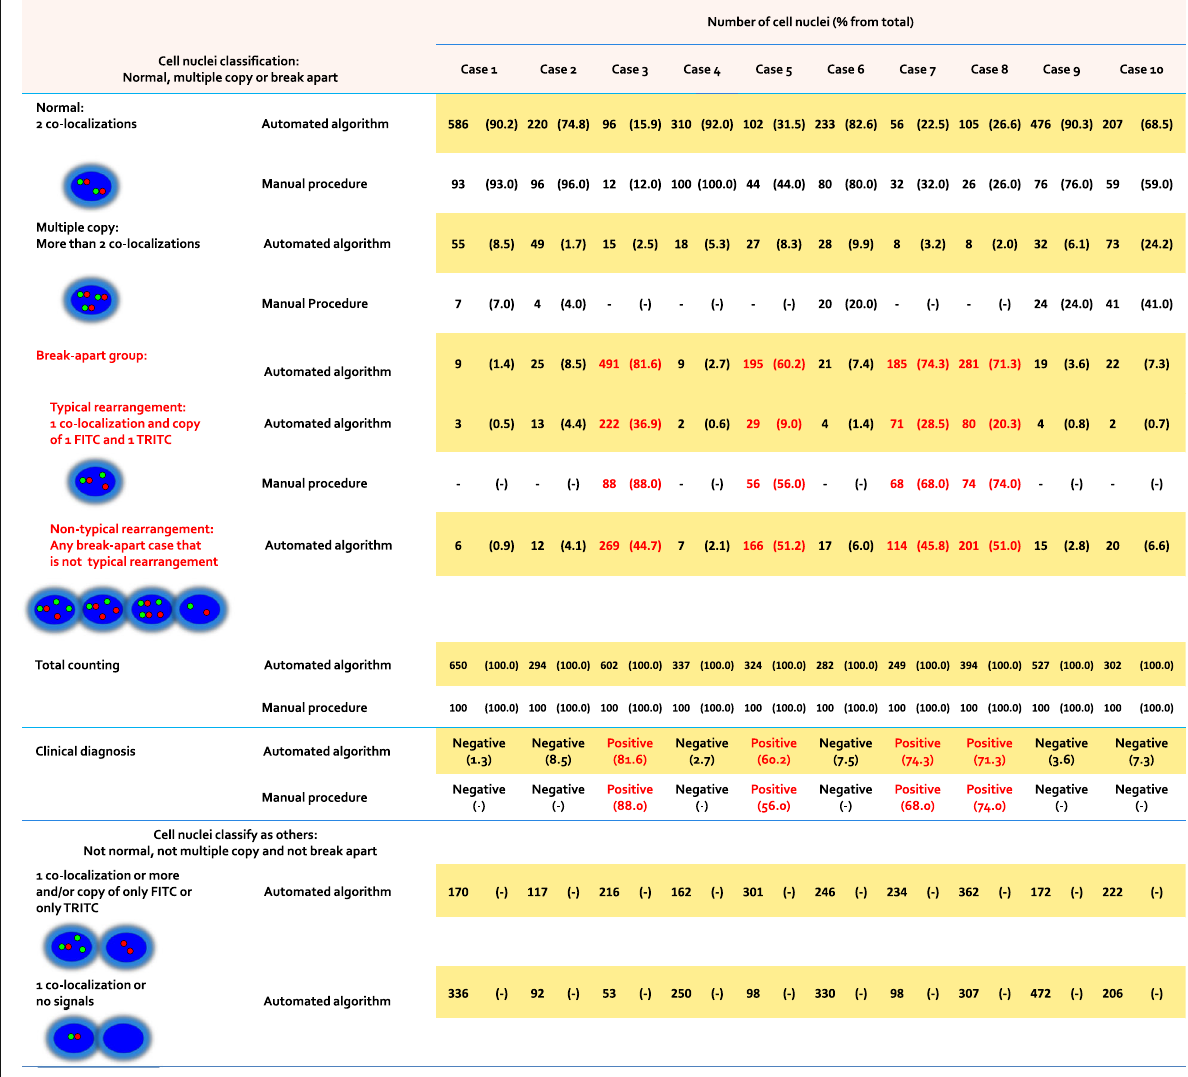
Fig. 5 3D FISH counting and scoring of individual cell nuclei with FITC (green) and TRITC (red) channels. Nuclei patterns are illustrated (left column: normal, multiple copy, break apart or others) and results are shown for the automatic and the clinical manual procedure (nuclei counting with percentage from total). Outcome of positive or negative diagnosis for the lymphoma and solid tumors patients are shown as